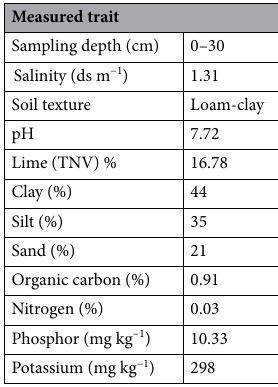
Table 4. Physico-chemical properties of